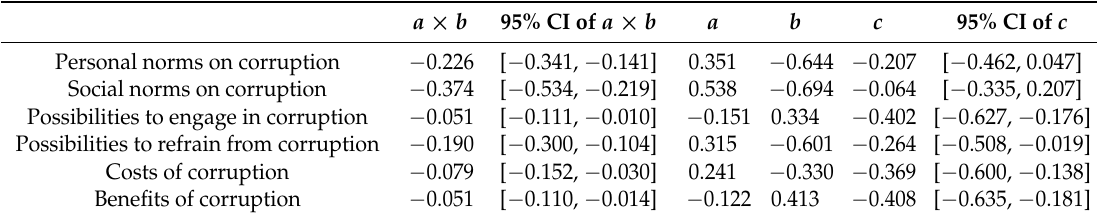
Table 4. Results of the mediation analyses ( n = 523).